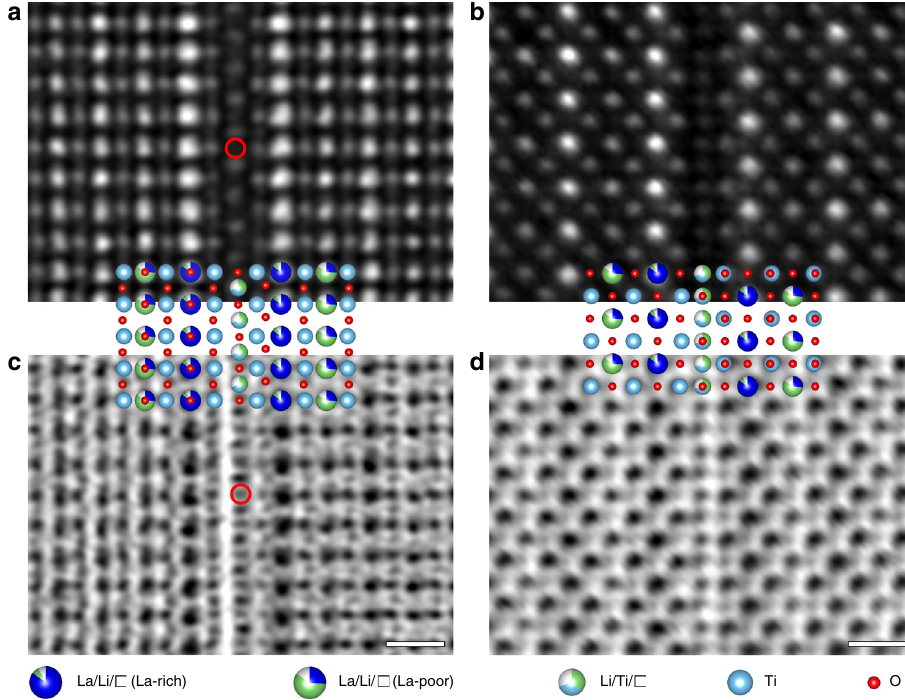
Fig. 3 Structural analysis of the 2D defects. a , c HAADF-STEM ( a ) and ABF-STEM ( c ) images of the defect when the adjacent LLTO was oriented along ½ 1 (cid:1) 10 (cid:2) . An atomic column consisting of O only was circled in red in a and c . b , d HAADF-STEM ( b ) and ABF-STEM ( d ) images of the defect when the p adjacent LLTO was oriented along ½ 010 (cid:2) . The scale bars in c and d are both 5 p